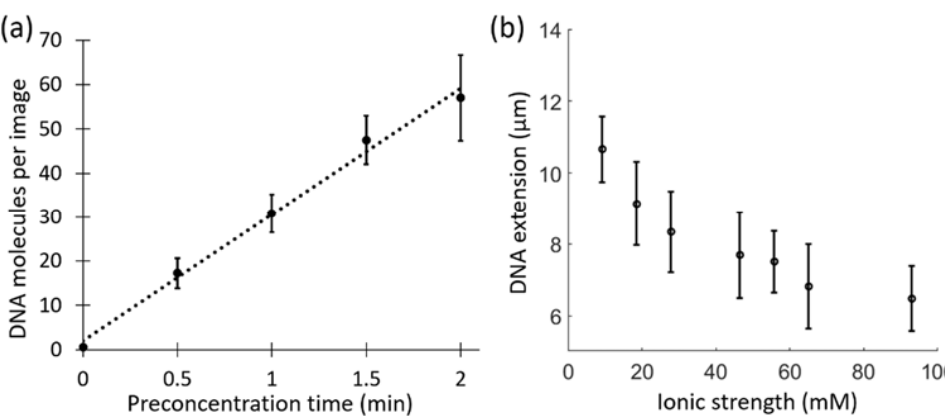
Figure 2. ( a ) The number of λ‐ DNA molecules collected per image with increasing preconcentration time. Error bars are the standard deviations from five images per time point. ( b ) λ‐ DNA extension at seven different ionic strengths measured simultaneously. Each point consists of data for at least 100 molecules. Error bars are standard deviations.